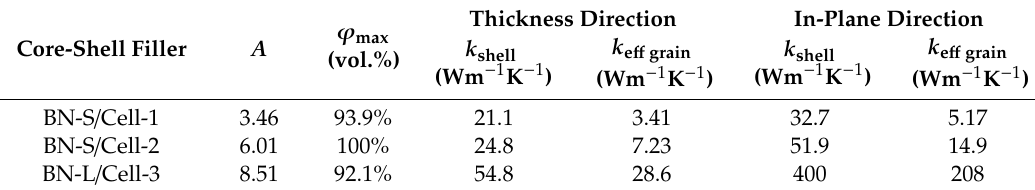
Figure 12. Thermal conductivity of composites with pristine h-BN platelets of Reference [19]. Lines Figure12. Thermalconductivityofcompositeswithpristineh-BNplateletsofReference[19]. Linesshow show the results of model calculations, symbols are measured values. the results of model calculations, symbols are measured values. Table 3. Model parameters of the plots shown in Figure 10. The fitted parameters are A , ϕ max , and k shell , while k e ff grain is calculated according to Equation (4). BN-S and BN-L refer to the filler shell material made of 8 and 18 µ m boron nitride platelets respectively. Cell-1, Cell-2, and Cell-3 refer to cellulose beads making the core of the filler of diameters 30, 40, and 35 µ m respectively. For details refer to Reference [19].